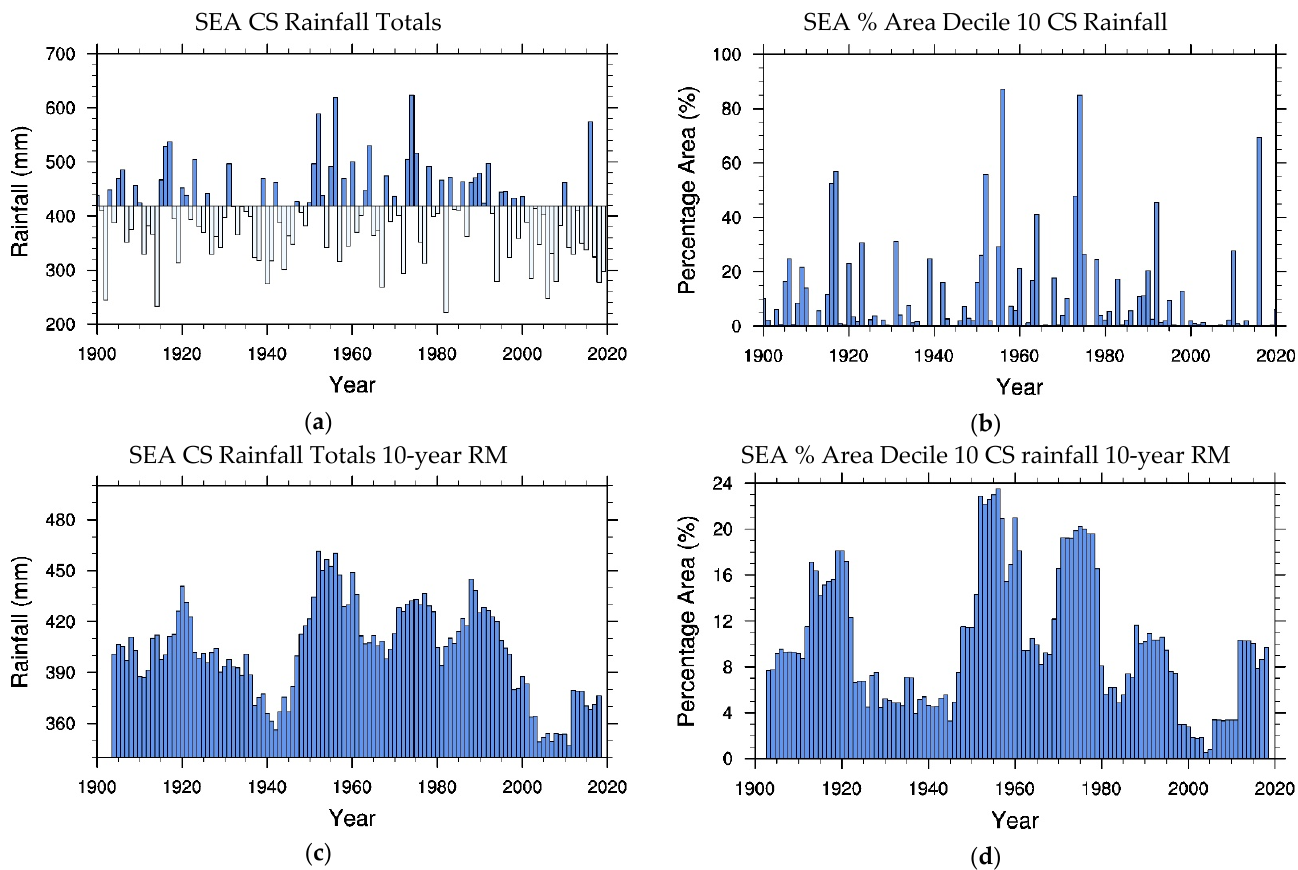
Figure 6. ( a ) SEA rainfall totals (mm) for April–October (CS), ( b ) percentage area (%) of SEA with rainfall in decile 10 (PAR D10 ) for CS ( c ) 10-year RM of SEA rainfall totals for CS and ( d ) 10-year RM of SEA PAR D10 for CS.